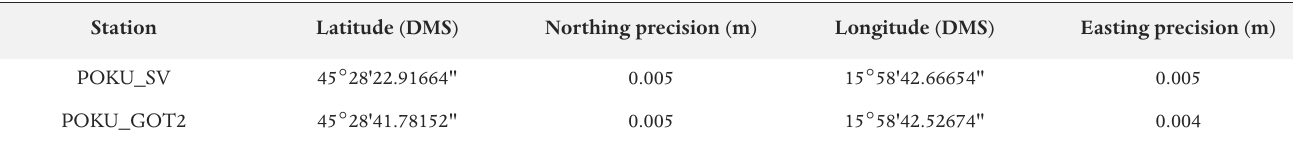
Table 3. Ellipsoidal coordinates with their precisions